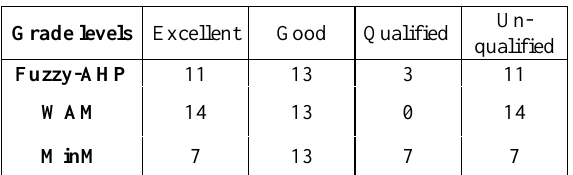
Figure 2 The comparison between the final scores obtained by three method.